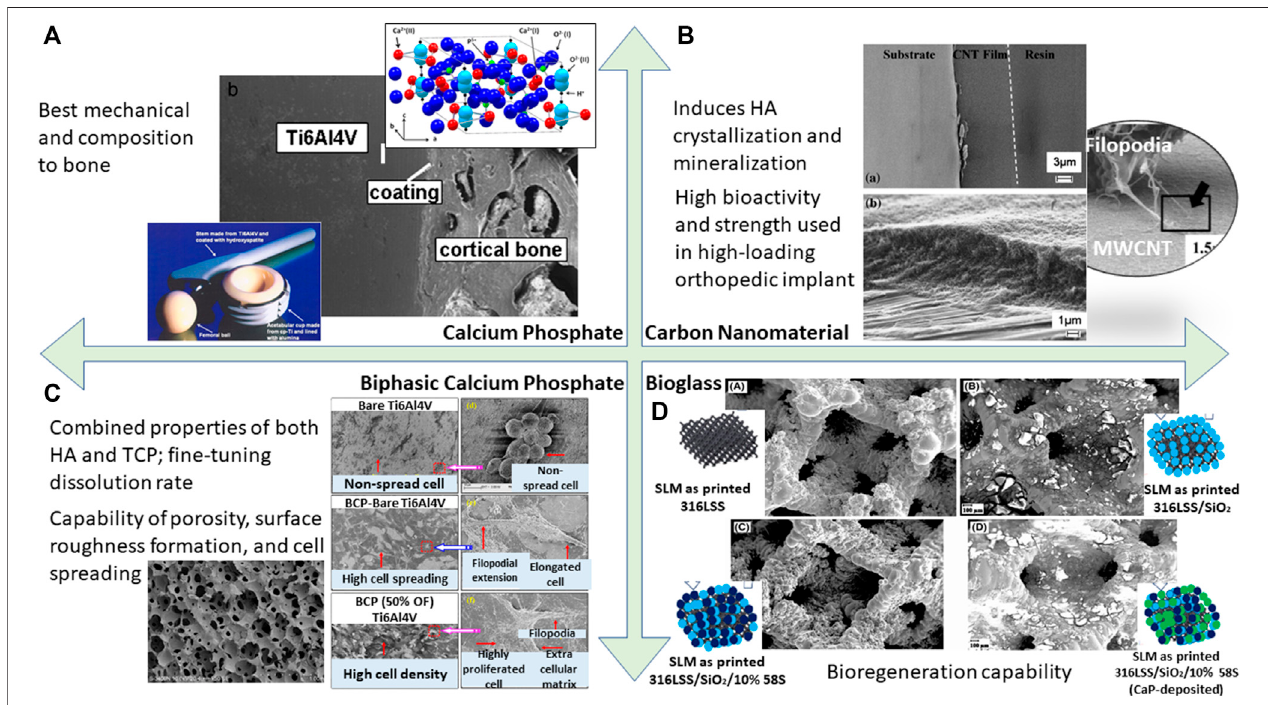
FIGURE 9 | A summary of bioactivity assessment conducted on different types of bioactive coating resulting in cell adhesion capability; (A) calcium phosphate (Heimann 2013). (B) Carbon nanomaterial (Li et al., 2011). (C) Biphasic calcium phosphate (Ebrahimi et al., 2017; Behera et al., 2020). (D) Bioglass (Tabia et al., 2021).